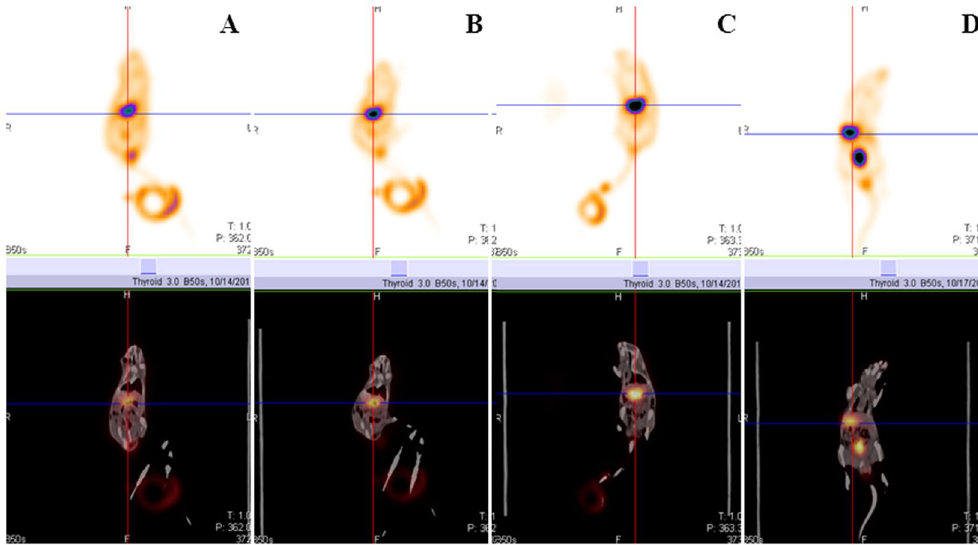
Figure 3. As compared with before EA group ( A ), the radioactivity uptake in the stomach was significantly increased during 2 Hz EA ( B ). The level of stomach Na 99m TcO4 uptake did not reached the peak until 180 min after EA ( C ), and then started to decrease 240 min after EA ( D